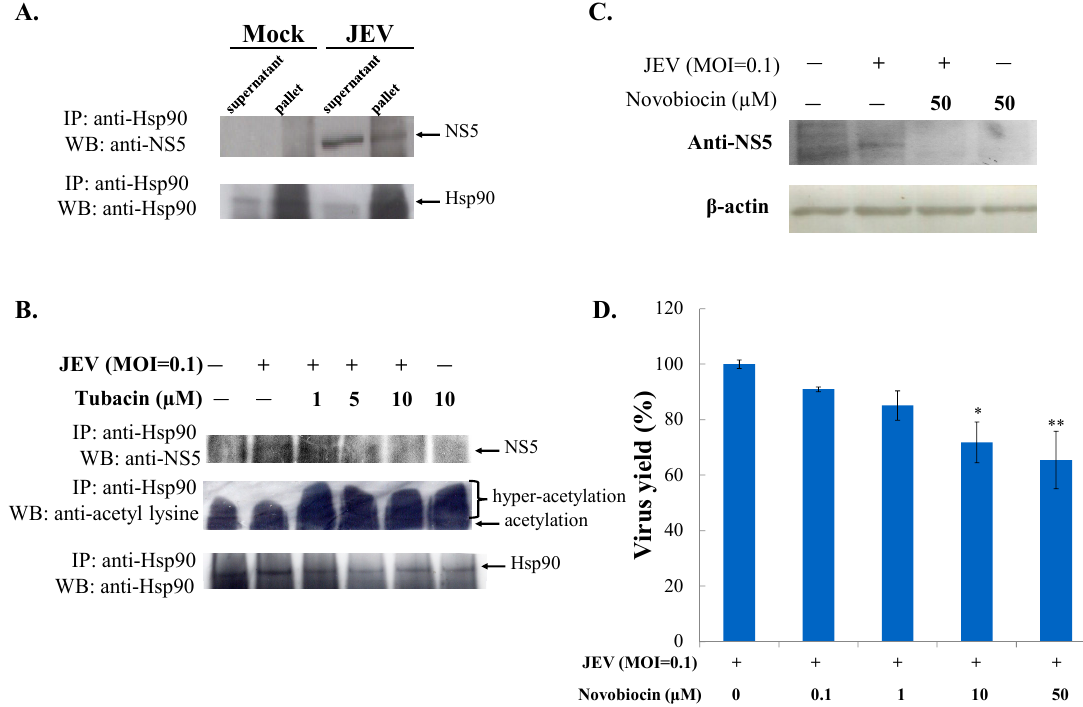
Figure 6. Protein-protein interaction, acetylation level, and function analysis of Hsp90 in JEV replication. For examining the interaction of Hsp90 with JEV NS5, co-immunoprecipitation assay was performed on the infected lysates. After centrifugation, lysate supernatants and precipitated pallets were further analyzed by Western blotting with anti-NS5 and anti-Hsp90 antibodies ( A ); For verifying the acetylation level of Hsp90, JEV infected cells treated with or without tubacin were harvested 36 h post infection; the lysate was accomplished using immunoprecipitation assay with anti-Hsp90 antibodies and protein A-Sepharose beads. The precipitates were examined by Western blotting with anti-NS5, anti-acetyled lysine, and anti-Hsp90 antibodies ( B ); For evaluating JEV NS5 expression in response to novobiocin, Western blotting analysis of infected cells was probed with anti-NS5 antibodies 36 h post infection ( C ); For studying antiviral activity of novobiocin, virus yield in the supernatant of treated infected cells was measured using plaque assays ( D ). * p value < 0.05; ** p value < 0.01 compared with untreated infected cells.